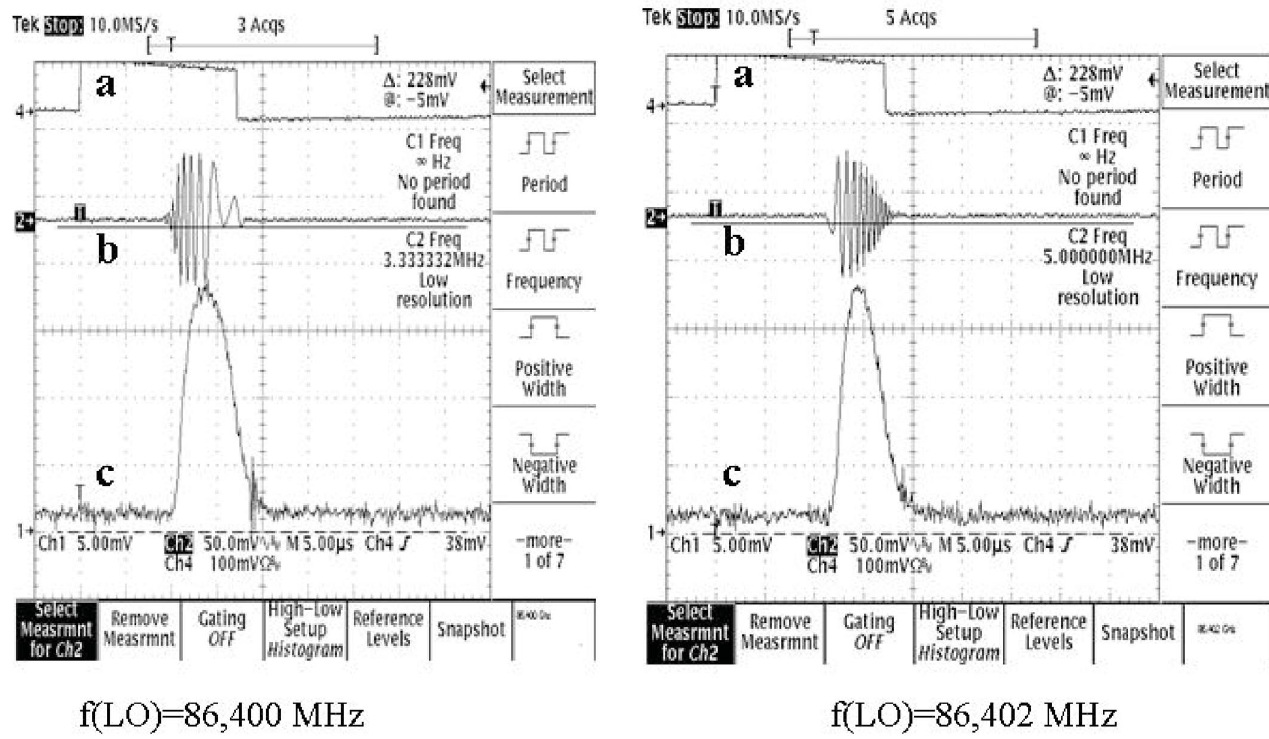
FIG. 5. Direct manifestation of the negative direction of the radiation chirp. Top trace: ( a ) e -beam current pulse. ( b ) heterodyne intermediate frequency (IF) output. ( c ) total W -band power. The local oscillator (LO) frequency f (cid:2) 86 400 MHz —the IF frequency decreases with time. Right: f frequency: Left: f LO